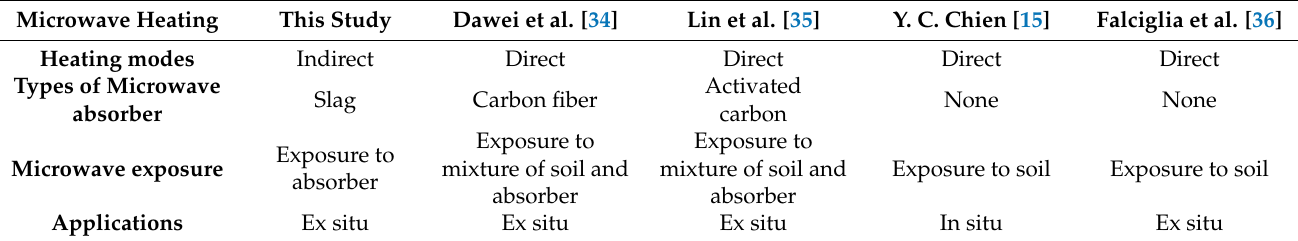
Table 3. Comparison of microwave heating technology.